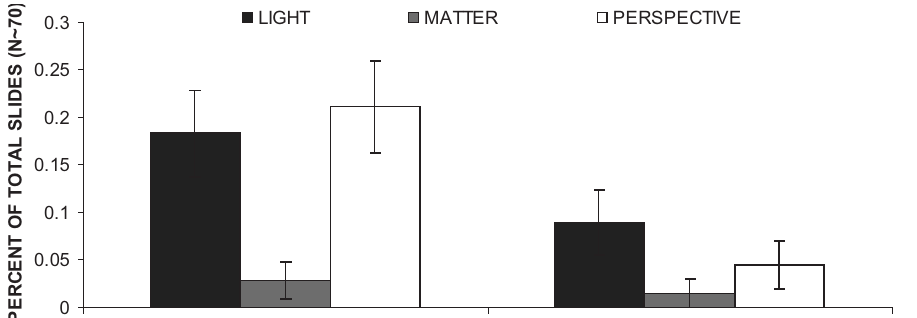
FIG. 2. The ratio of point to- tals from topic area B for each in- terpretive theme to the total num- ber of slides used during these lectures. Error bars represent the standard error on the